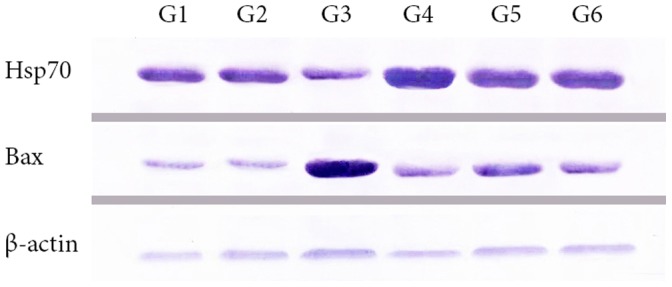
Western blot analysis with Hsp70 and Bax mouse monoclonal antibody.Corresponding β-actin blots are shown as a control for sample loading. G1, normal control; G2, complex control; G3, lesion control; G4, reference control; G5, zinc (II) complex (2.181×10−5 M/kg); G6, zinc (II) complex (4.362×10−5 M/kg).